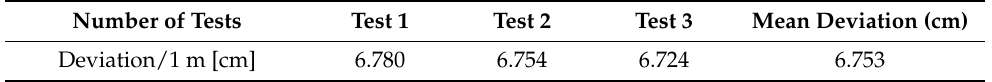
Table 1. Wheels’ Deviations over Straight Path.